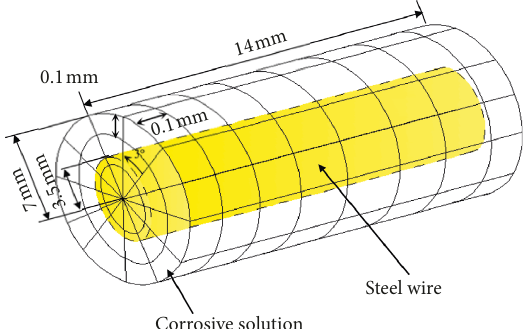
Figure 2: Schematic diagram of CA model for the corrosion process of high-strength steel